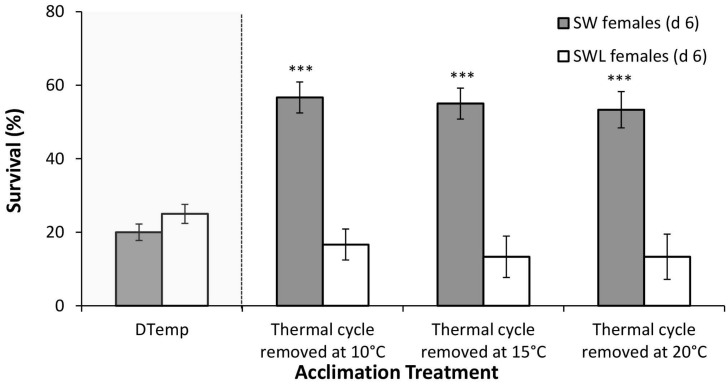
Mean survival (±S. E. M.), as a measure of Rapid Cold Hardening (RCH) ability, of d 6 Calliphora vicina females either developed on sugar, water and liver (SWL), or sugar and water (SW) only.RCH was assessed as survival at their respective discriminating temperatures (DTemp—in shaded grey area for comparison) following a 6 d thermal cycle (between 10 and 20°C) at which adults were removed at either 10°C, 15°C or 20°C. * denotes significant differences from DTemp at p<0.05, ** at p<0.01 and *** at p<0.001 (Bonferroni post-hoc). 6 replicates of n = 10 for each data point.